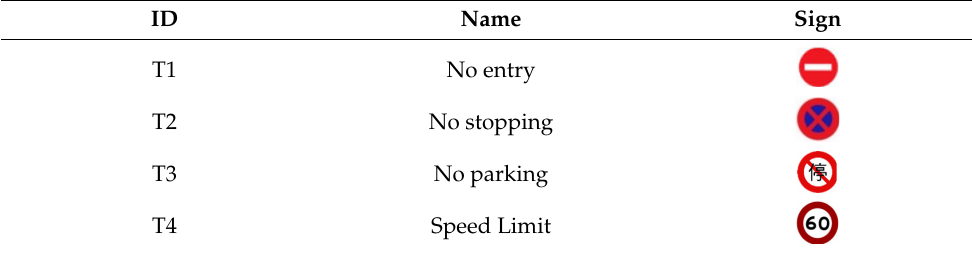
Table 1. Taiwan Prohibitory Signs.